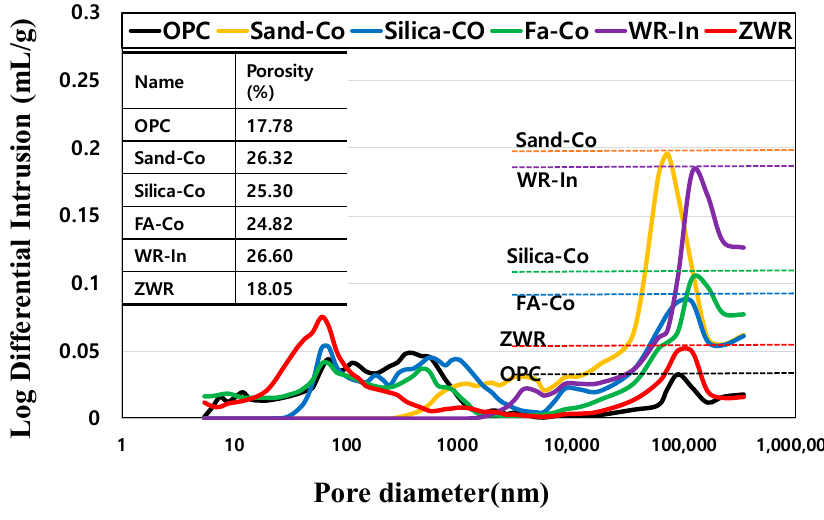
Figure 13. Results of the mercury intrusion porosimetry (MIP) test after 28 days.